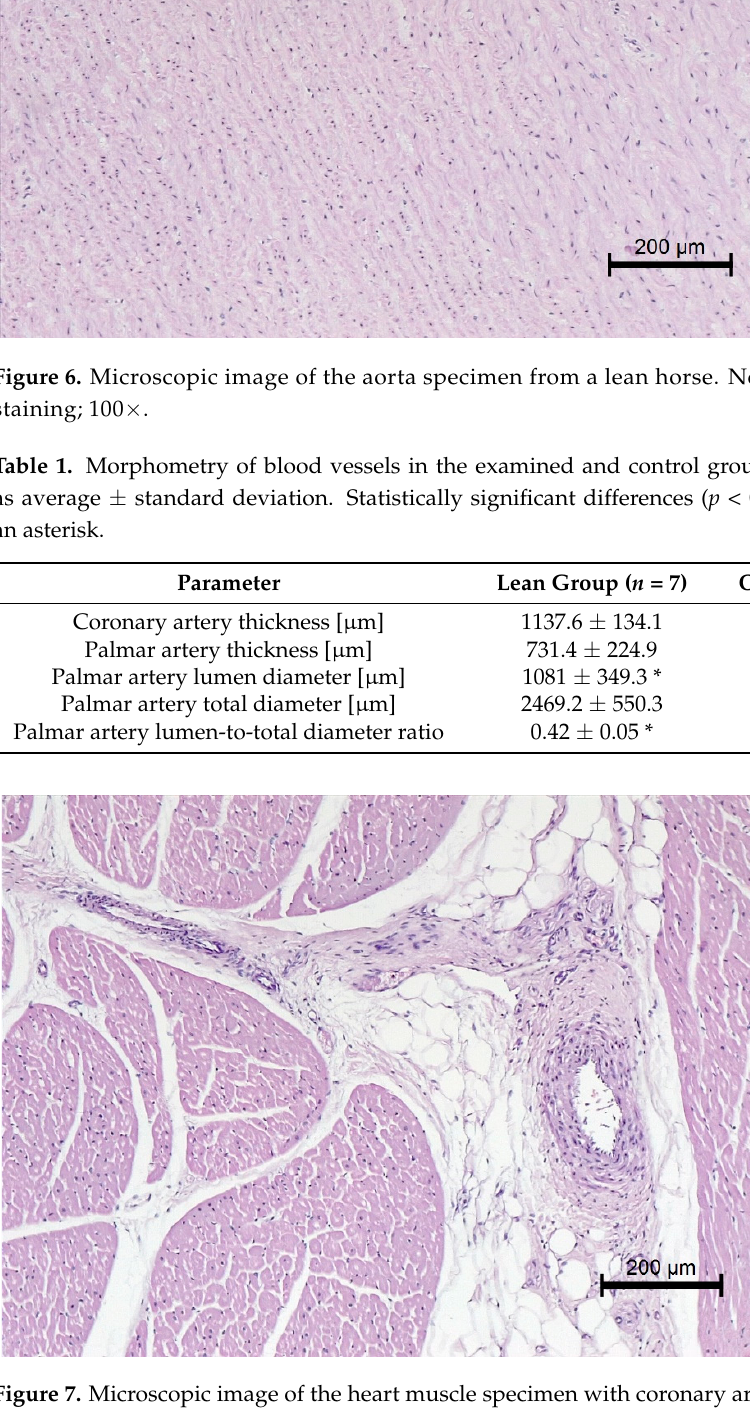
Figure 8. Microscopic image of the heart muscle specimen with coronary artery from an extremely obese horse. The wall of the right ventricle: in the center, a coronary vessel with a thickened wall; moderate degeneration of muscle cells; intense perivascular steatosis; HE staining; 100×.